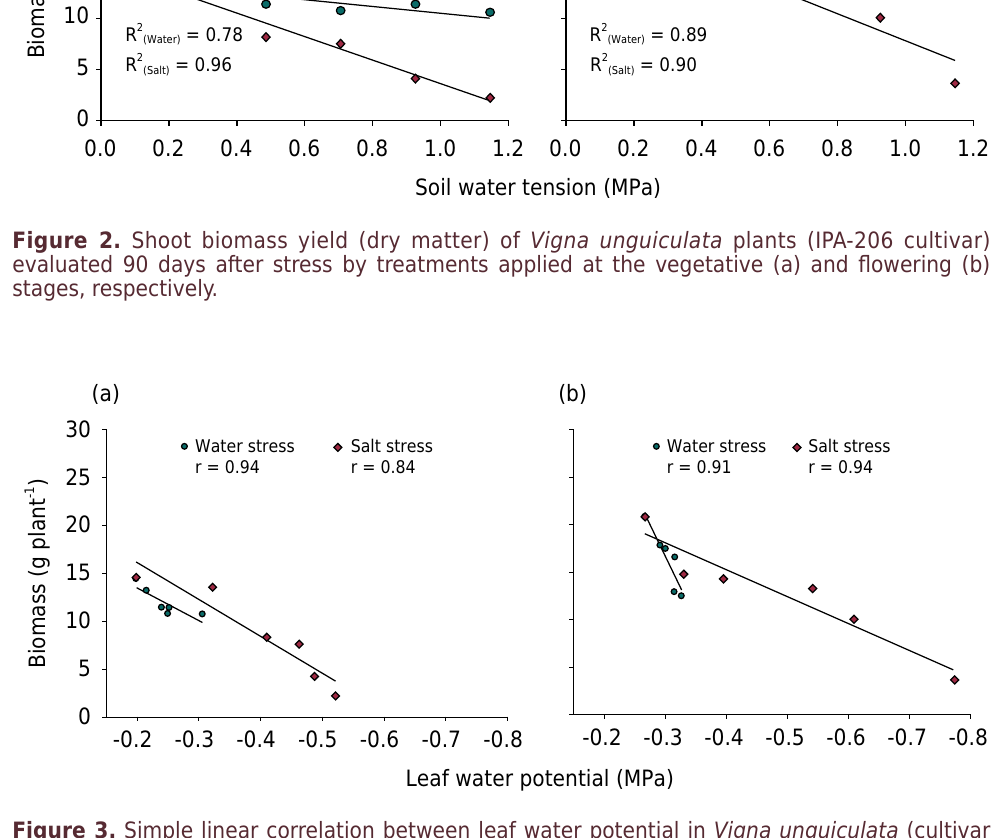
Figure 3. Simple linear correlation between leaf water potential in Vigna unguiculata (cultivar IPA-206) as measured 7 days after stress and shoot biomass yield (dry matter) for treatments applied at the vegetative (a) and flowering (b) stages for each soil water